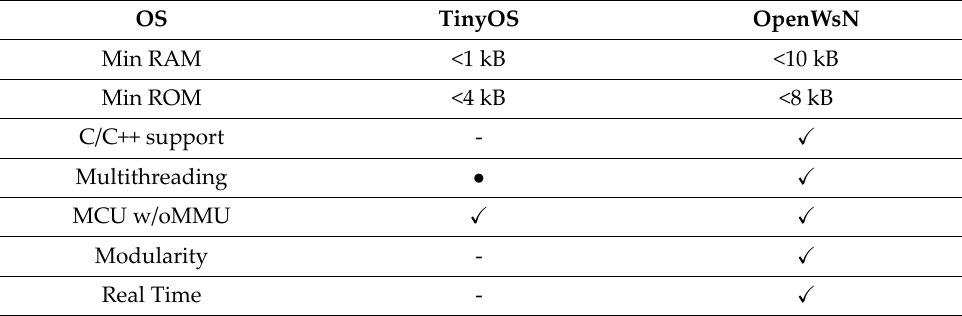
Table 1. Tinyos and Openwsn.